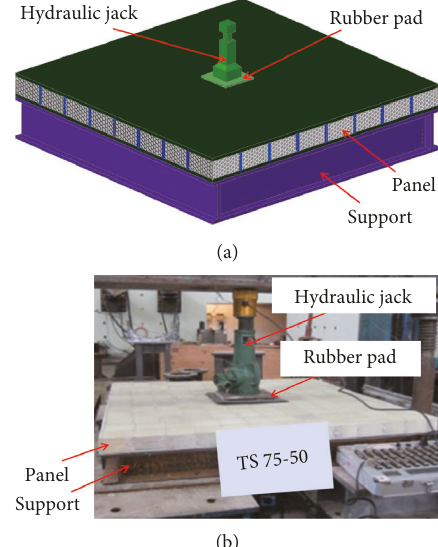
Figure 5: Concentrated loading test setup: (a) schematic diagram and (b)